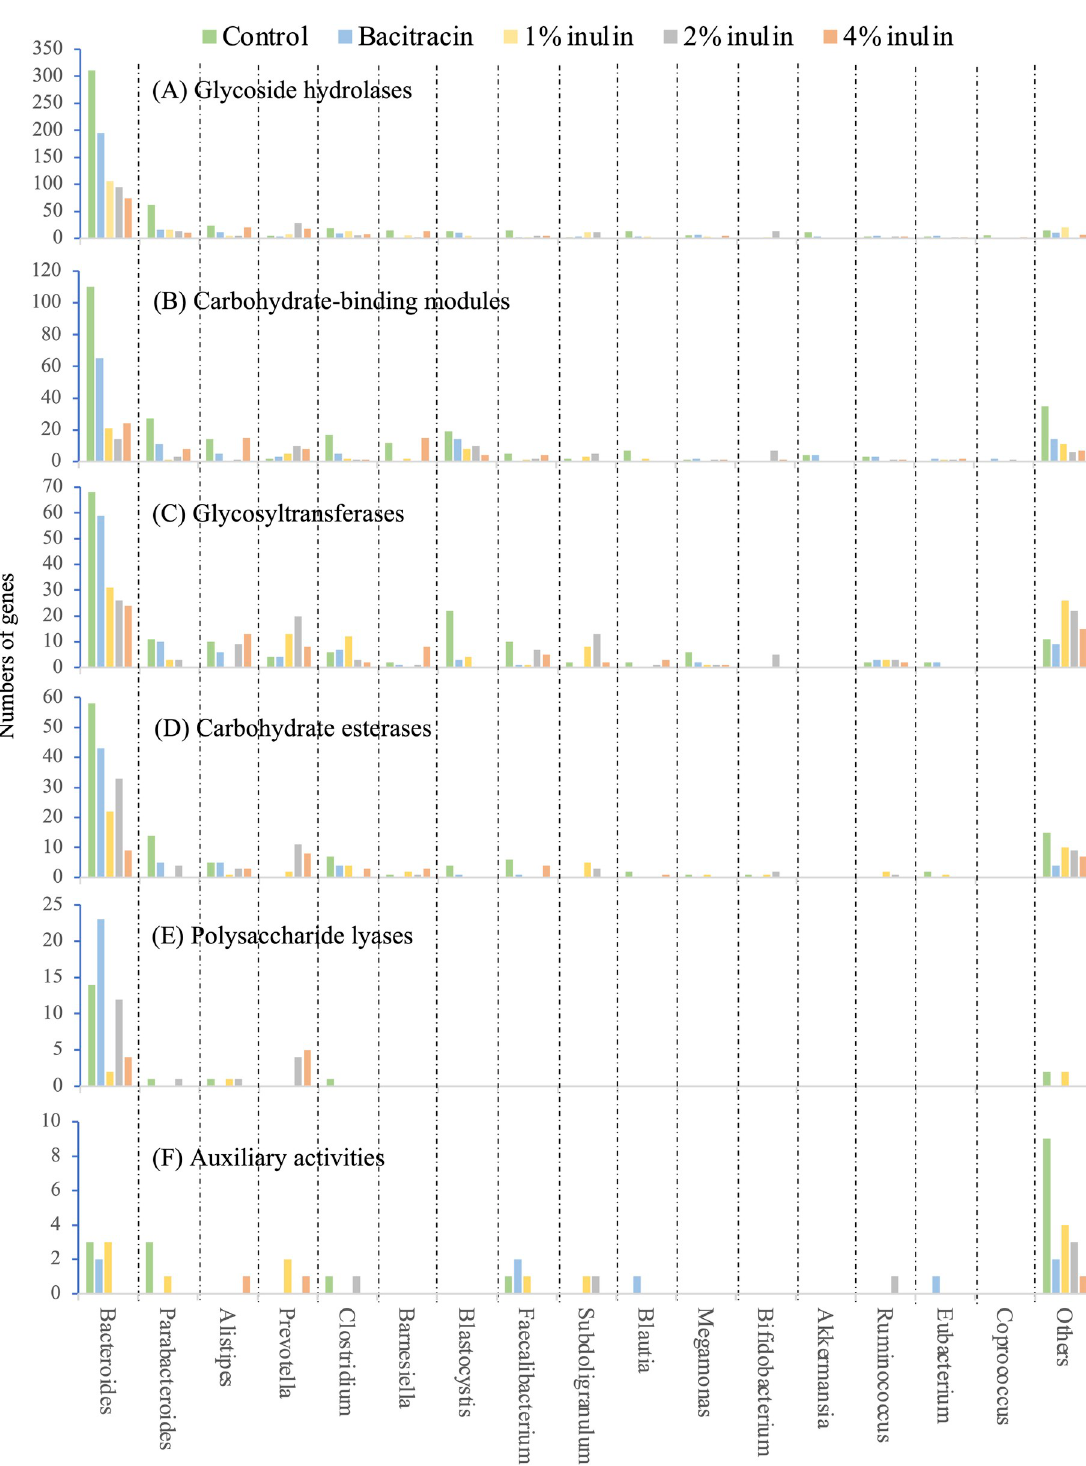
Fig 4. Phylogenetic composition of carbohydrate metabolizing genes and their expression numbers in the cecal microbiota of broilers fed a basal diet supplemented with 0 (control), 1%, 2% or 4% inulin or 400 ppm bacitracin.